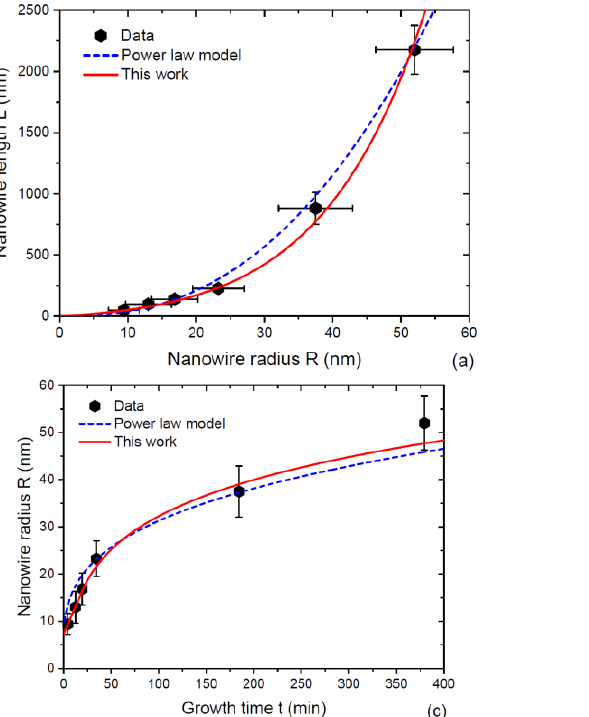
Figure 7. Evolution of the morphology of self-induced GaN NWs grown by MBE at 780 °C: ( a ) length versus radius, ( b ) length versus the NW growth time, ( c ) radius versus the NW growth time, and ( d ) volume versus the NW growth time. Symbols represent the data from Ref. [42]. The dashed lines are the fits by the scaling power-law model from Ref. [42], with a power exponent of 2.46. The solid lines are the fits obtained within the modified model of this work with the parameters summarized in Table 2. Table 2. Fitting parameters for self-induced GaN NWs grown by MBE.